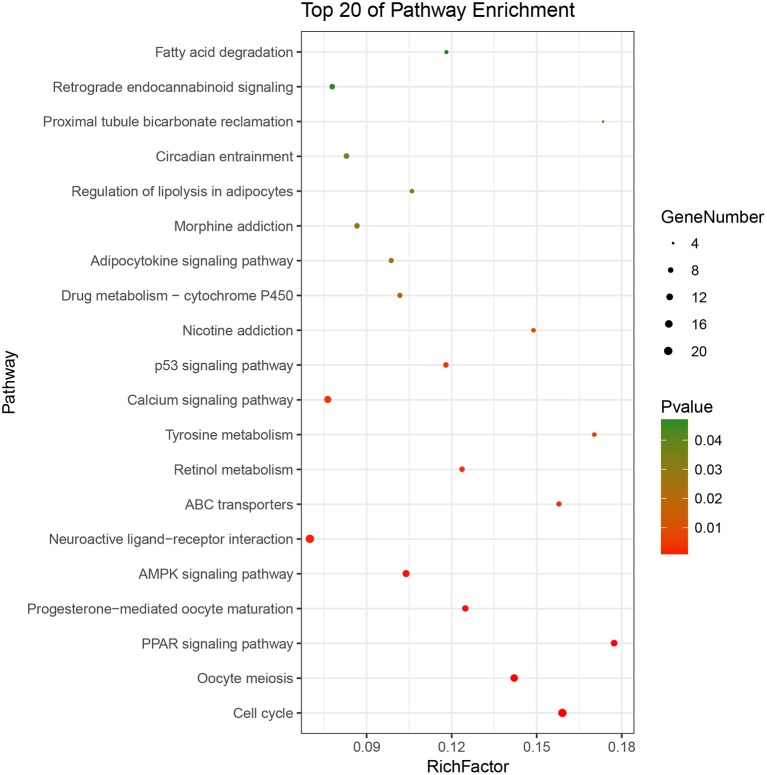
Pathways enrichment map of lncRNA-related mRNAs. Kegg terms were selected according to P < 0.05 and the most significant of the top 20 pathways were selected for visualization.